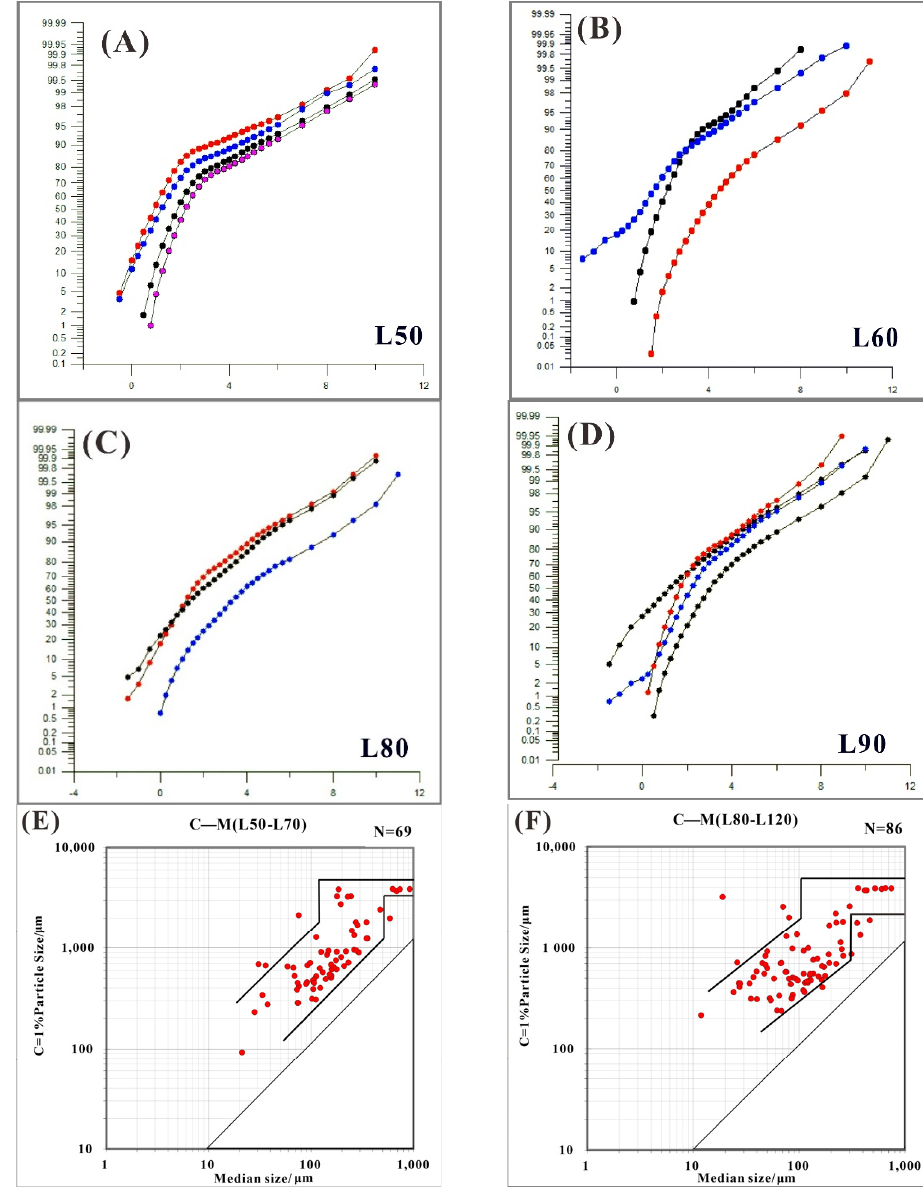
Figure 5. The probability cumulative grain size curves and C − M diagram. ( A ) The probability